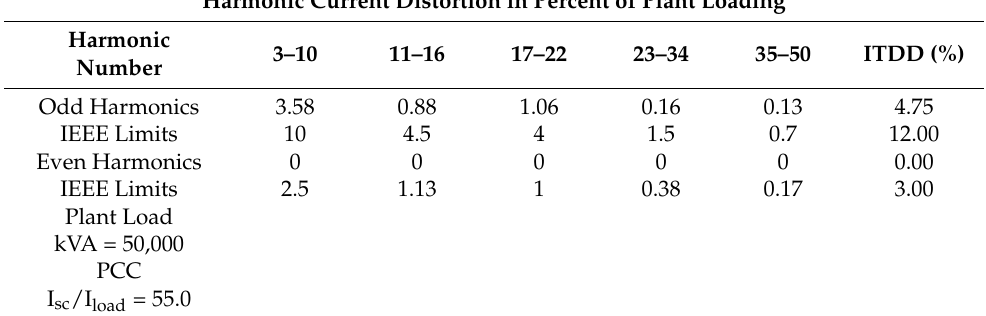
Table 9. ESA calculation results for IEEE Std. 519 current report with filter-1.